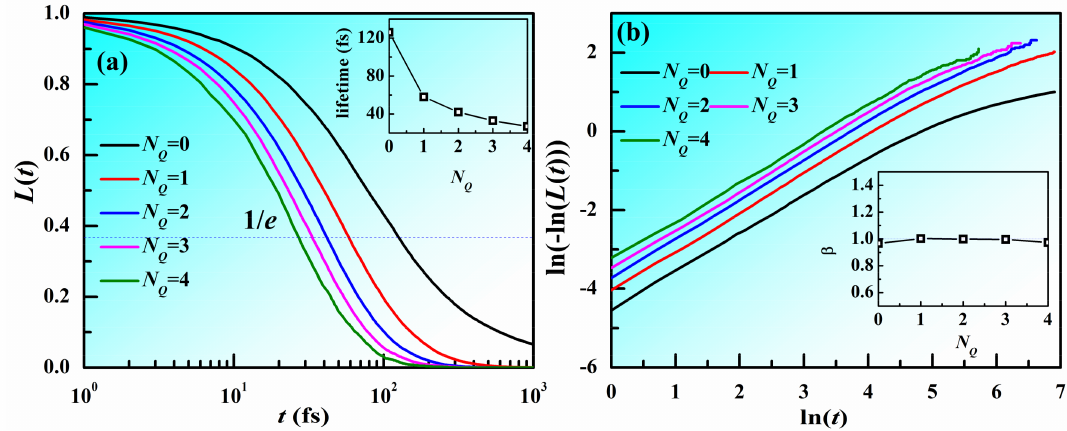
Figure 5. Lifetime for atoms with different N Q in Zr 50 Cu 50 MG at 300 K. ( a ) Lifetime function ( L ( t )) for different N Q as a function of time t . Inset is the lifetime of different N Q . ( b ) ln( − ln( L ( t ))) vs. ln( t ), inset is the slope with ln( t ) within [0, 3] as a function of N Q